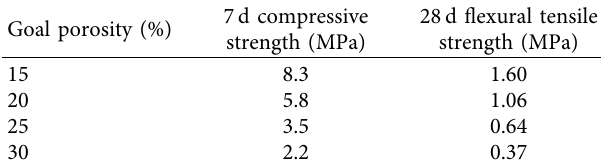
Table 12: Summary table of average strength of porous